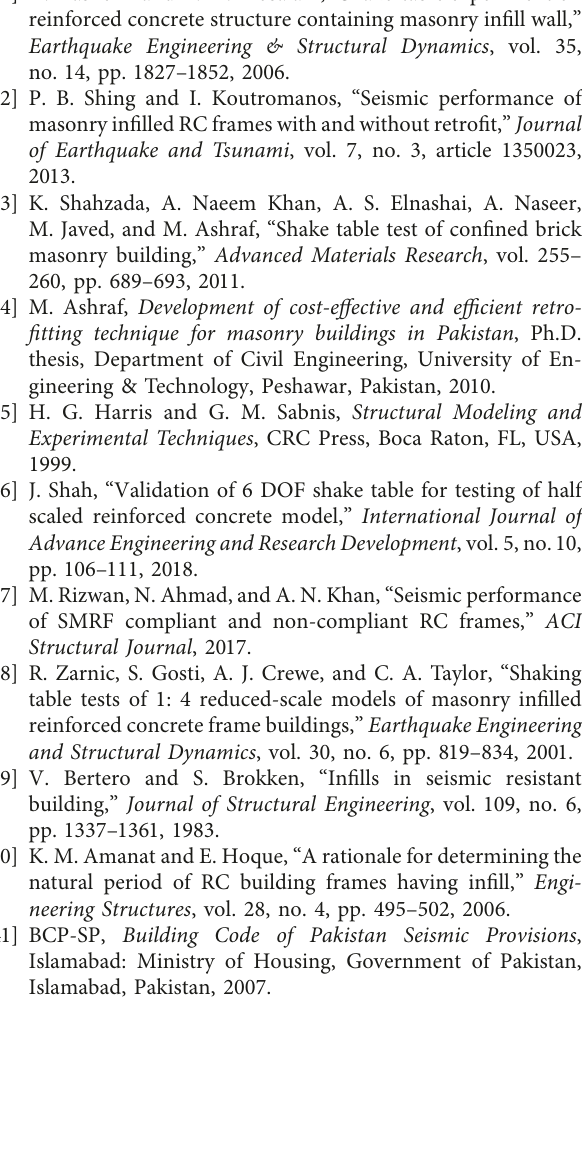
table tests of 1: 4 reduced-scale models of masonry